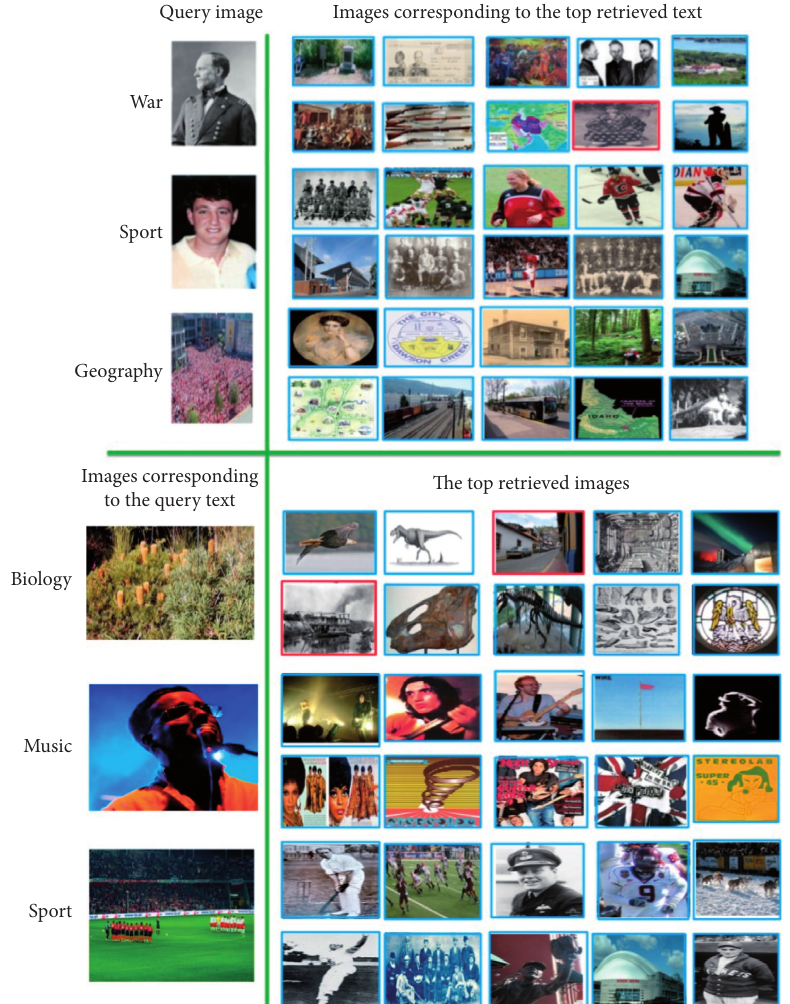
Figure 6: Image queries and the corresponding top retrieved images, and text queries and the corresponding top retrieved